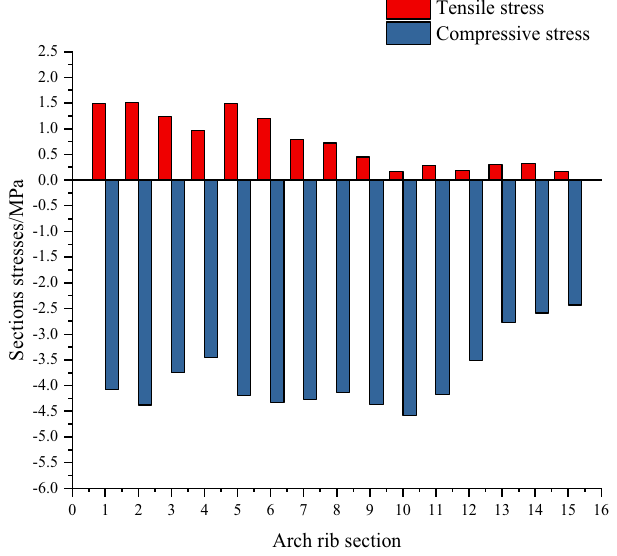
Figure 22. Stress ranges of the lower edge of arch rib key sections.